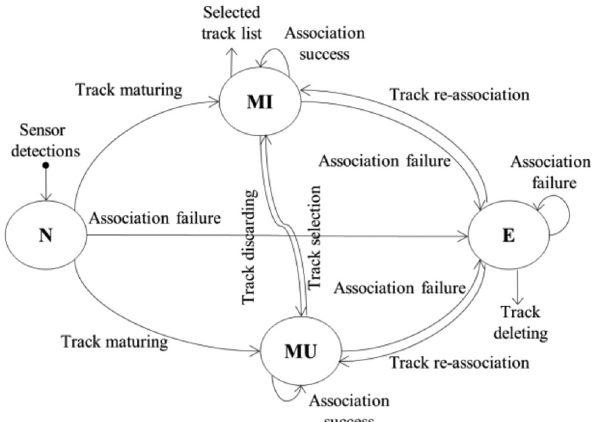
Figure 2 State transition of the track life